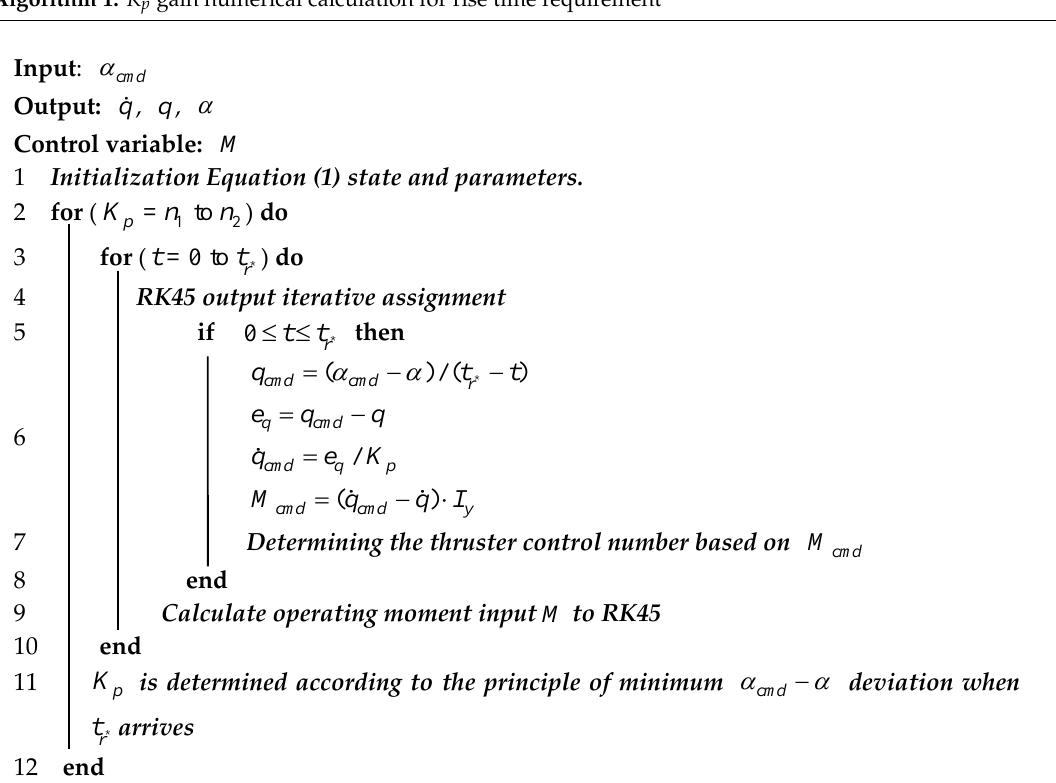
Algorithm 1: K p gain numerical calculation for rise time